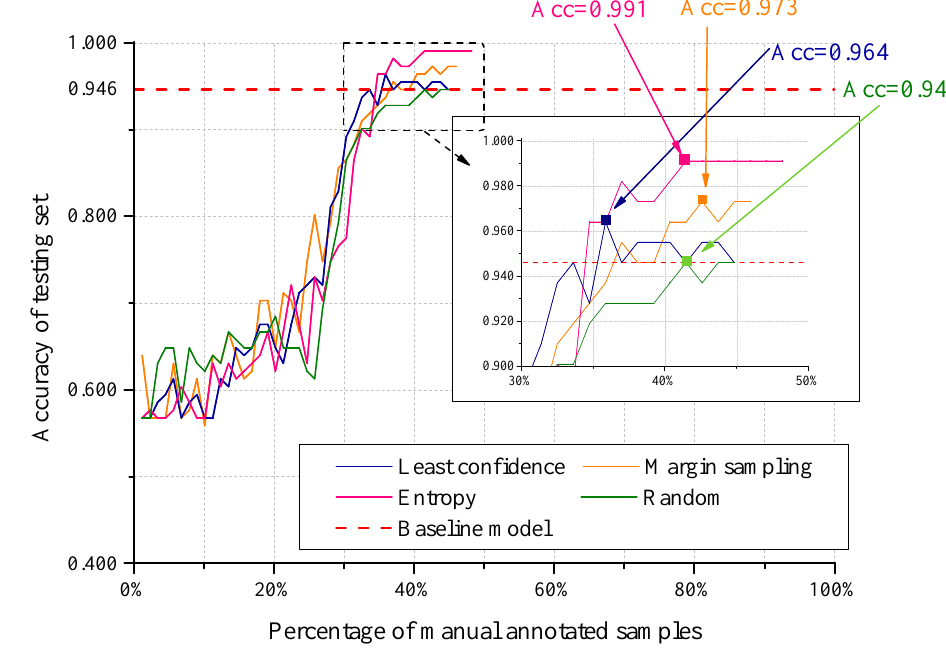
Figure 8. Comparison of least confidence, margin sampling, entropy and random